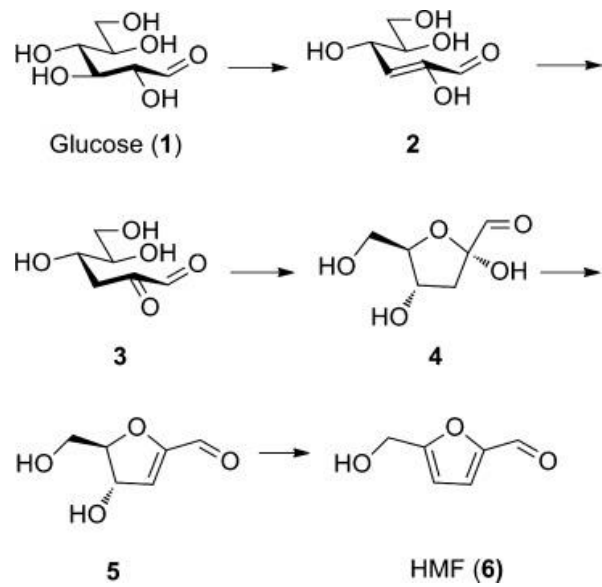
Figure 16. The 3-Deoxy-2-ketohexose mechanism for formation of HMF. Reproduced with permission from [45]; copyright (2011), John Wiley & Sons, Inc. Catalysts 2019 , 9 , x FOR PEER REVIEW